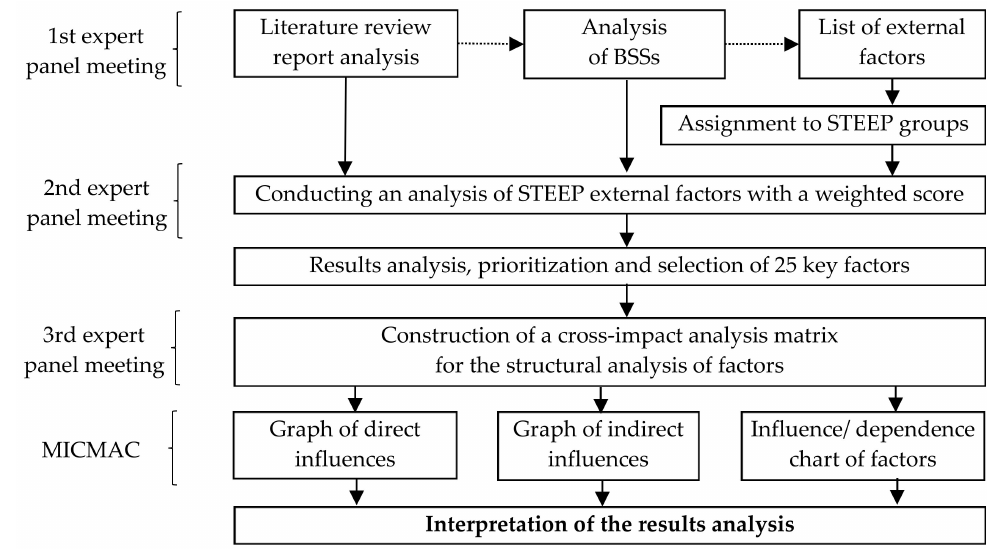
Figure 3. Research procedure using expert